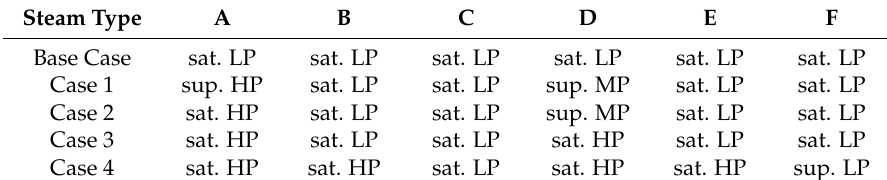
Table 1. Steam types in different cases for heat integration.